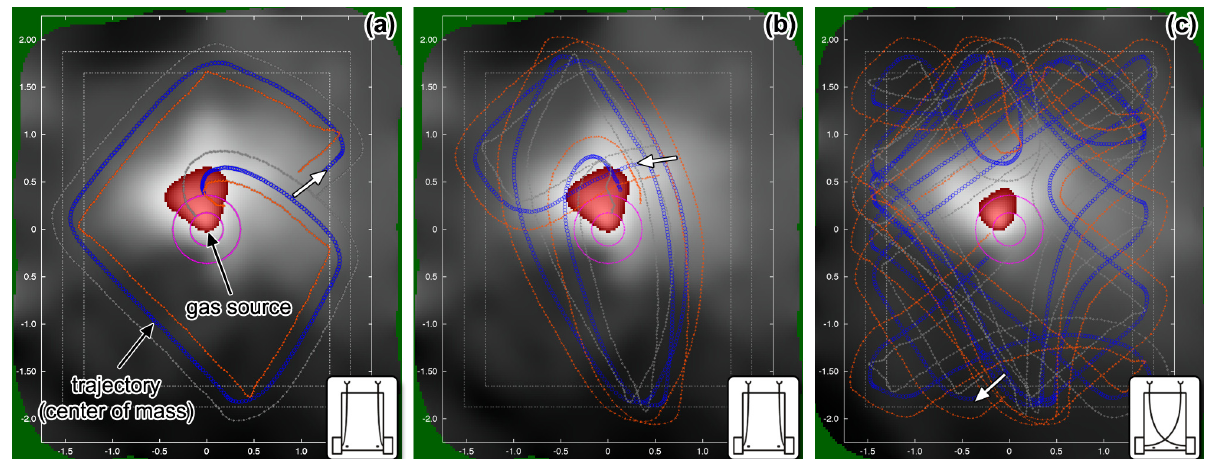
Figure 19 . Example paths of the Braitenberg vehicle plotted on top of the gas concentration gridmap calculated from all the trials of the corresponding sequence with the mapping method by Lilienthal and Duckett described in Section 6. The path of the robot’s centre is indicated by small circles, while the position of the front corners is plotted using small dots. The starting position and the initial heading of the corresponding trial are marked by an arrow. Also shown are the boundaries of the testbed area by two broken lines that mark the area where the robot is exposed to an increasing repellent force. The clearance area of the gas source, which was located in the middle of the testbed area in all trials shown, is indicated by two circles (the outer one is derived by obstacle growing assuming a circular